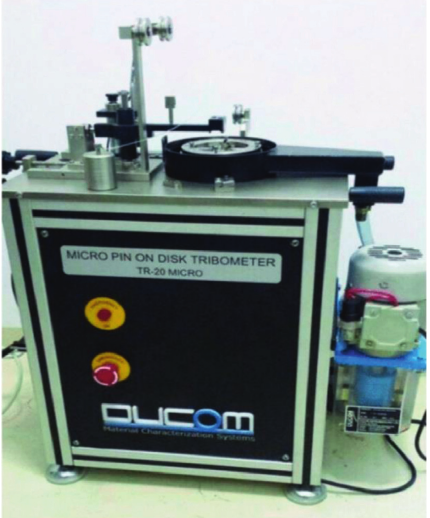
Figure 1: Pin-on-disc tribometer.